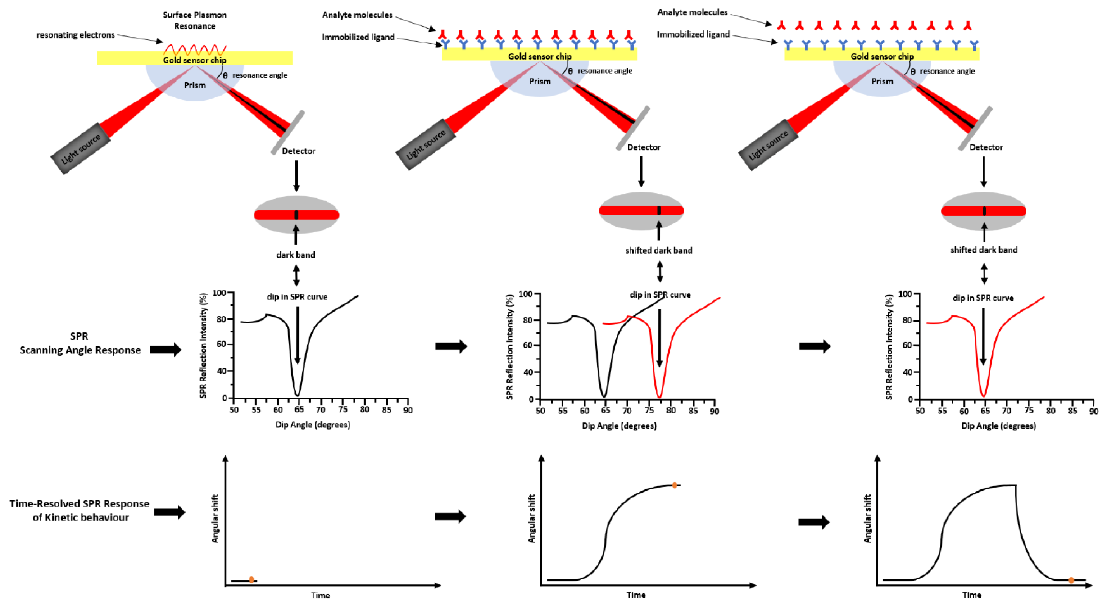
Figure 3. Surface plasmon resonance—ATR via the Kretschmann configuration. Light is focused onto a metal film through a glass prism and the subsequent reflection is detected. At a certain incident angle (or resonance angle), the plasmons resonate at the same light frequency, resulting in the absorption of light at that angle. This determines a dark line in the reflected beam. That dark line contains a wealth of information. The resonance angle can be obtained by observing a dip in SPR reflection intensity. A shift in the reflectivity curve represents a molecular binding event taking place on or near the metal film, or a conformational change in the molecules bound to the film. By monitoring, this shift vs. time is possible to study the molecular binding events and binding kinetics.